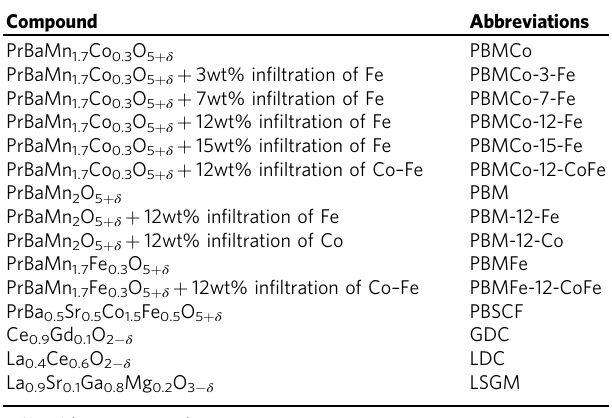
Table 1 Nomenclature for the compounds based on the